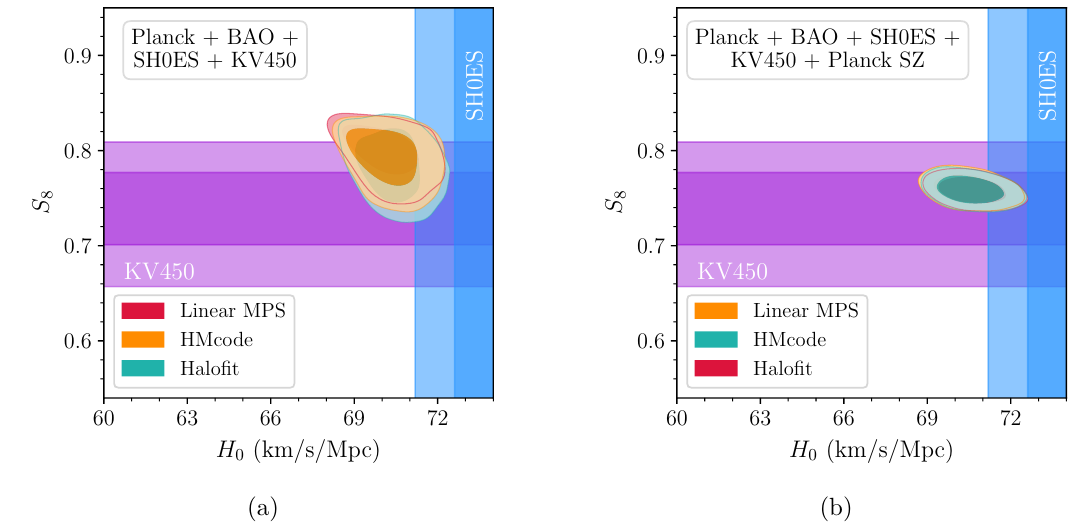
Figure 18. Same plots as in figure 13(b) (left) and figure 14 (right) but with two types of non-linear corrections to the matter power